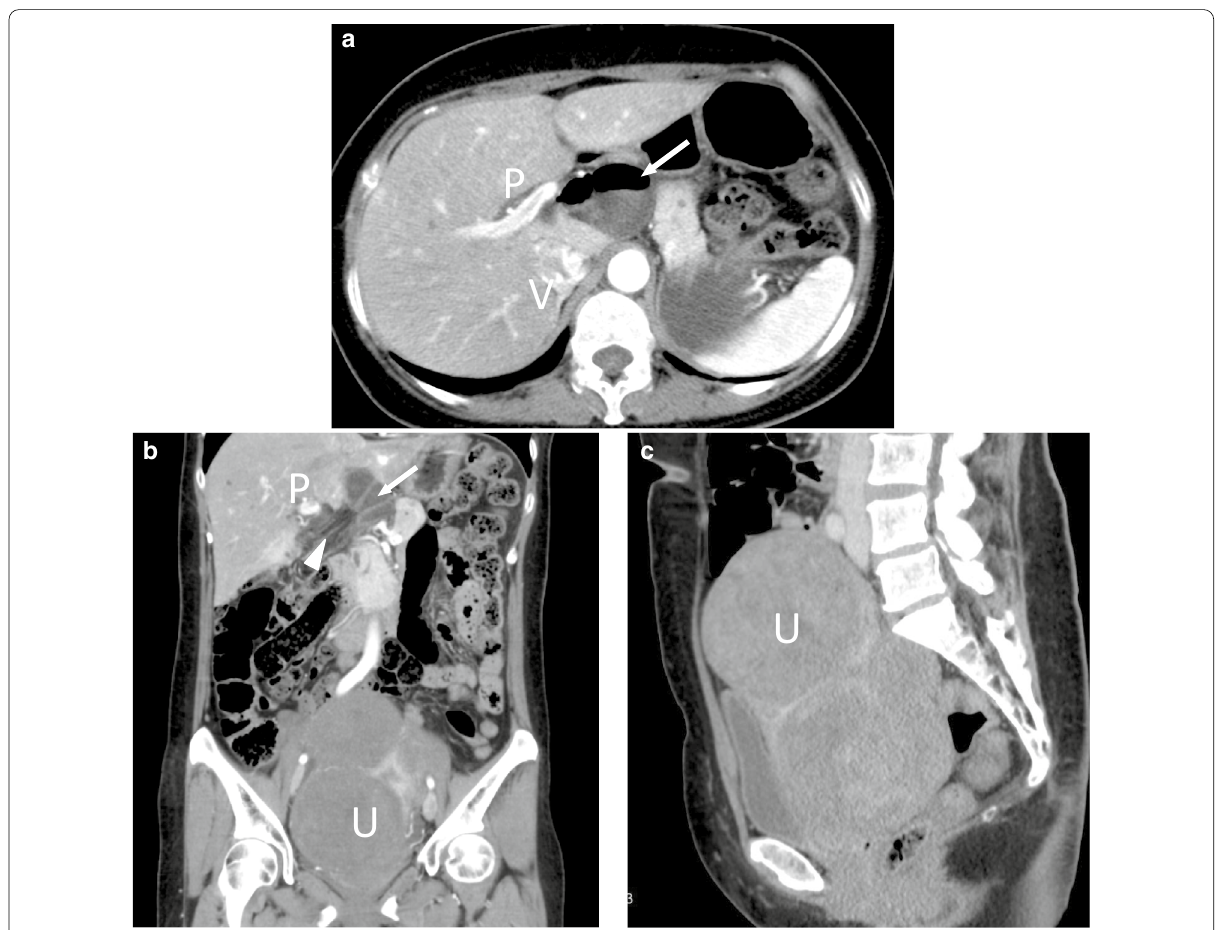
Fig. 1 Abdominal contrast-enhanced computed tomography. a Axial image shows the dilated small bowel loop (arrow) between the portal vein (P) and the inferior vena cava (V). b Coronal image shows stretched and converging mesenteric vessels toward the foramen of Winslow (arrowheads). There are large uterine fibroids in the pelvis (U). Arrow and P indicate small bowel loops and portal vein, respectively. c Sagittal image shows the large uterine fibroids that are huge enough to occupy the pelvis